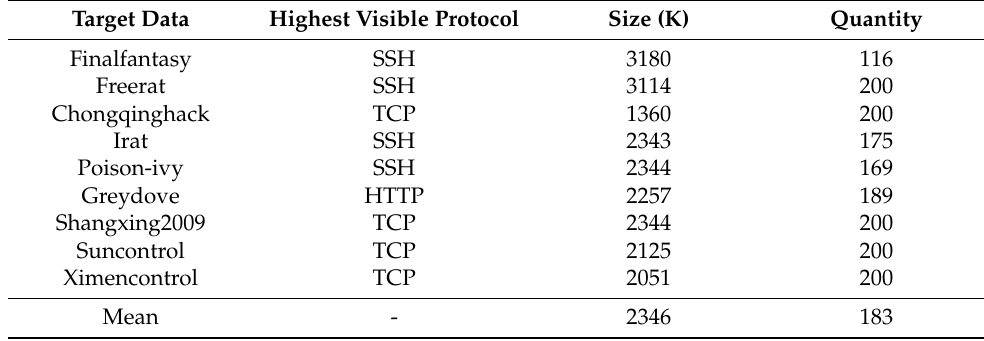
Table 2. Target dataset